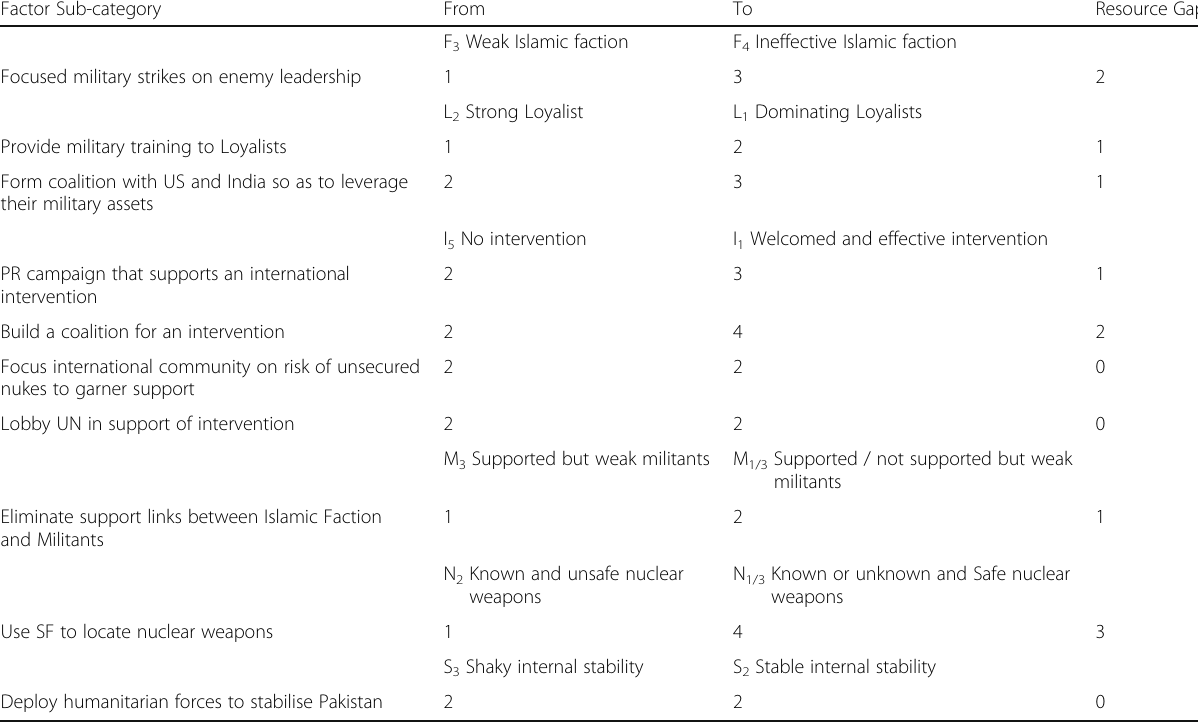
Table 7 Evaluating the resource gap for each option and their sub-ordinate tasks Factor Sub-category From To Resource